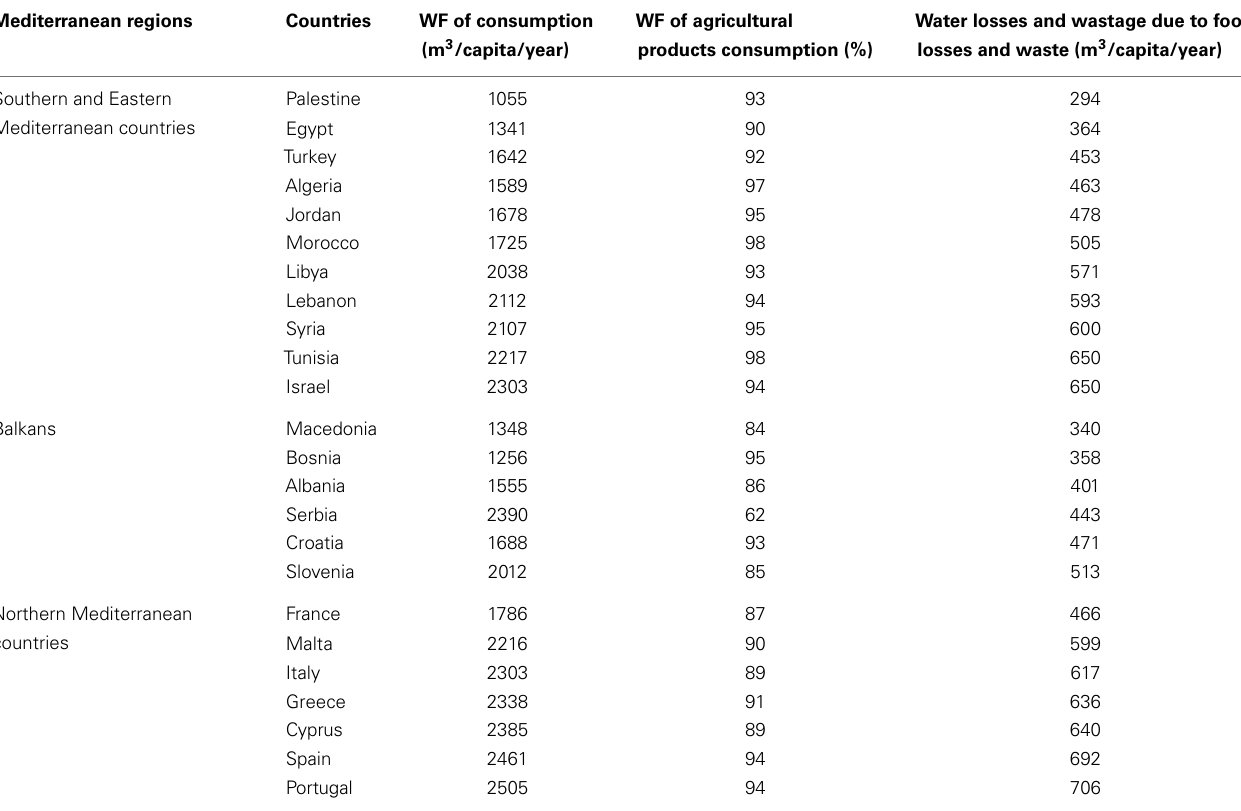
Table 10 | Estimates of water losses and wastage in the Mediterranean countries